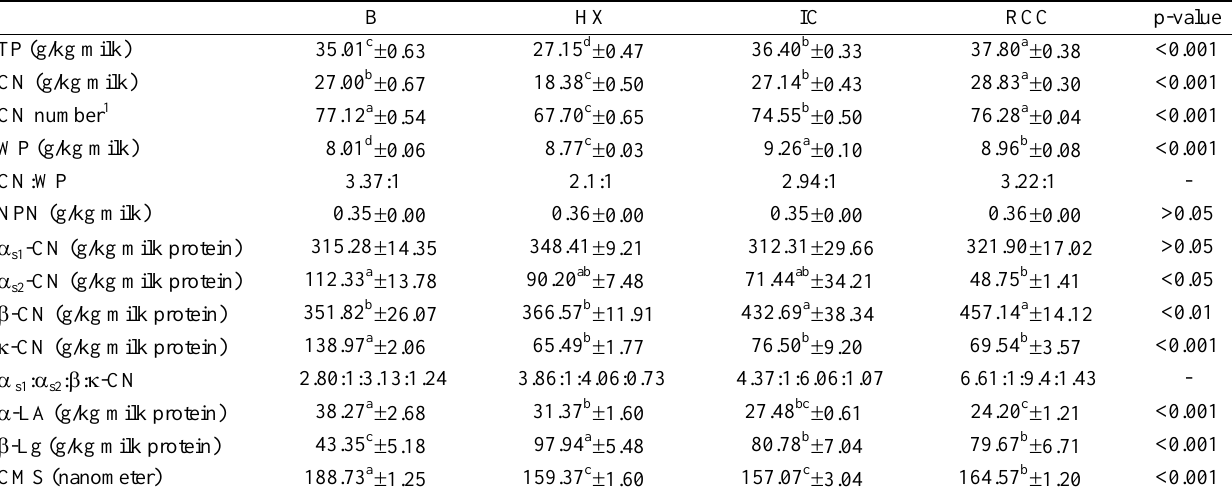
Table 1. Protein composition and casein micelle size (CMS) of buffalo (B), Holstein cross (HX), Indigenous cattle (IC) and Red Chittagong Cattle (RCC)